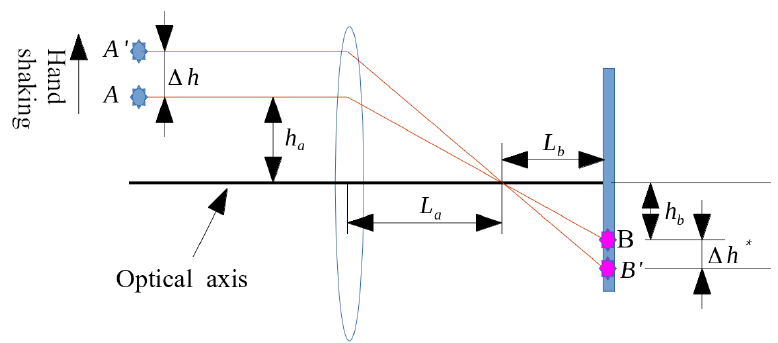
Figure 4. Desired movement of lens holder to compensate for the image blur caused by hand shaking.